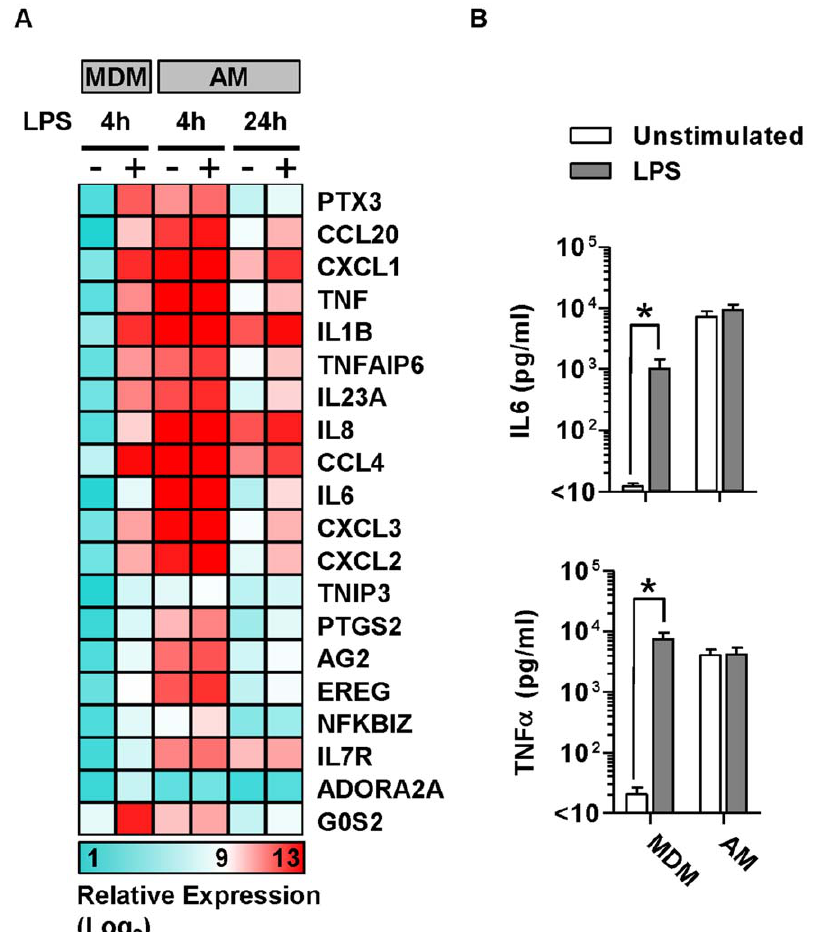
Figure 3. Inflammatory responses by freshly isolated AM. (A) Mean relative gene expression levels are presented in MDM and AM before and after 4–24 hour LPS stimulation, for the top 20 most upregulated genes following four hour LPS stimulation of MDM. (B) AM show extremely high baseline expression of pro-inflammatory genes which is not further upregulated following four hour LPS stimulation, however, after 24 hours in culture, basal inflammatory gene levels are reduced in AM, and LPS induced upregulation becomes evident. High basal pro-inflammatory cytokine levels which are not increased by LPS stimulation are also present in AM culture supernatants. Bars represent mean 6 SEM for at least 4 separate experiments (*denotes p , 0.05,